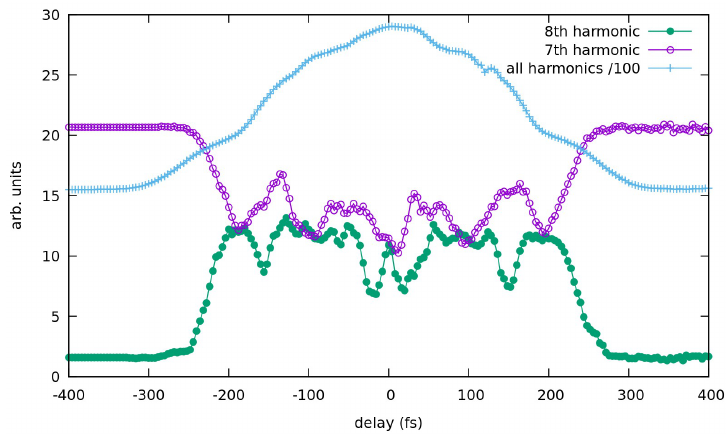
Figure 7. The contribution of different frequency ranges to the HHG radiation as a function of the delay between the infrared and the THz pulses for the same amplitudes as in Figure 6. Negative delays mean that the THz pulse arrives first. For the n th individual harmonic, the integral of the spectrum for an interval of the length of 0.6 ω L that is centered around n ω L is shown. For ”all harmonics”, the integration runs from 1.5 ω L to 30 ω L .